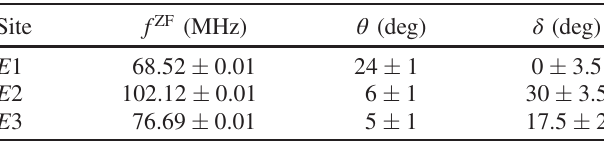
TABLE I. ZF precession frequencies f ZF , θ and δ values describing the internal field orientation for E 1 − E 3 at T ¼ 2 . 2